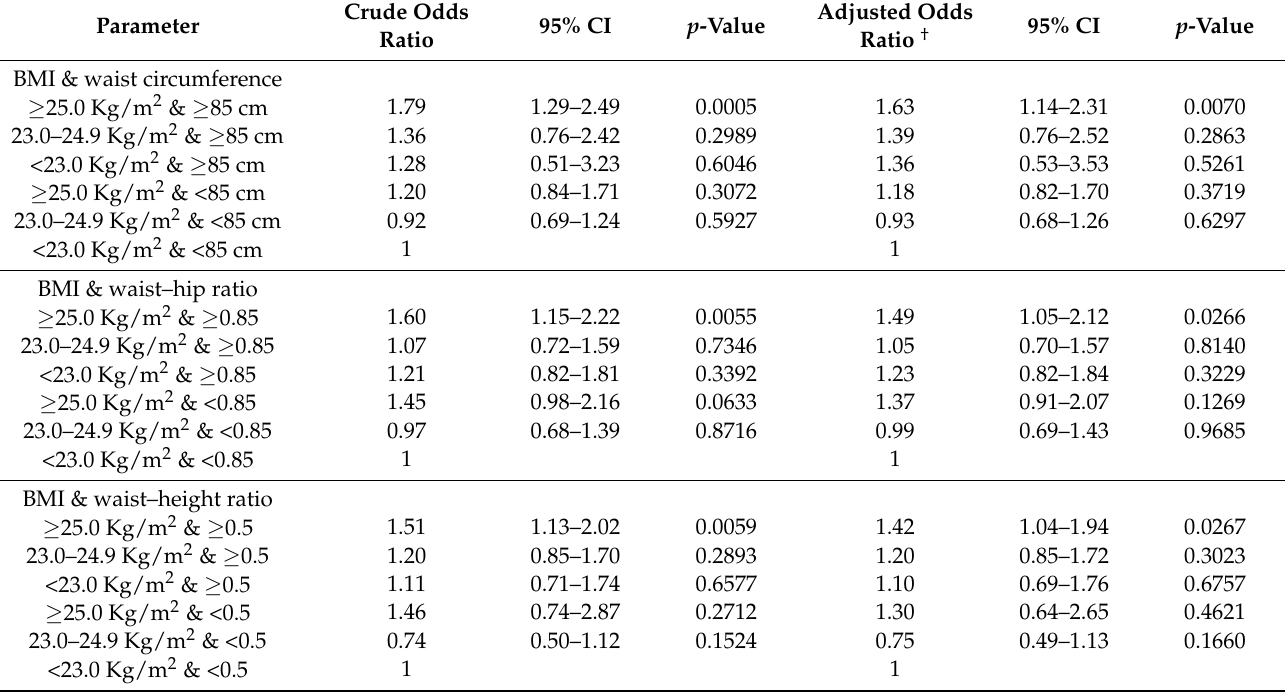
Table 3. Associations between abdominal obesity, BMI, and thyroid cancer